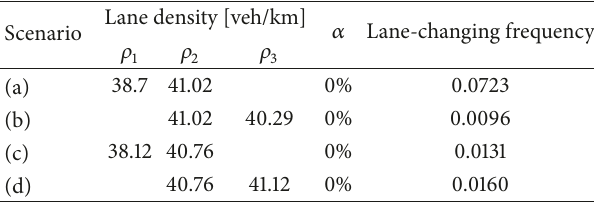
Table 1: Turning points in the fundamental-diagram-like curves of 𝑓 𝑖,𝑗 over densities.